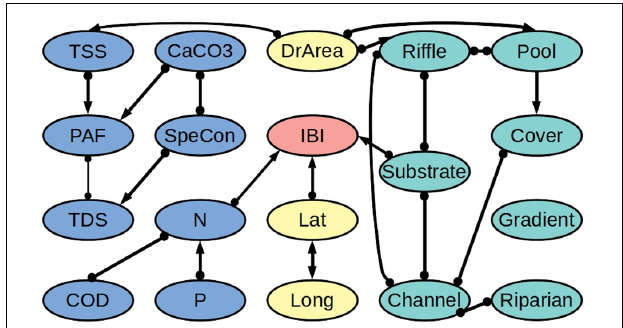
FIGURE 3 | Network of ecological relationships for the freshwater fish assemblage Index of Biotic Integrity (IBI) in Ohio, showing the relationships among the IBI (red), the water quality variables (blue), the physical habitat quality variables (turquoise), and the out-of-stream variables (yellow). Upstream variables are mainly connected to their downstream partners and are excluded from the figure to improve readability. The thickness of a connection indicates how many of the bootstrapping samples it appeared in. The abbreviations are explained in Table 2 . A summary of the bootstrapping results is provided in Supplementary Tables 1–3, 7